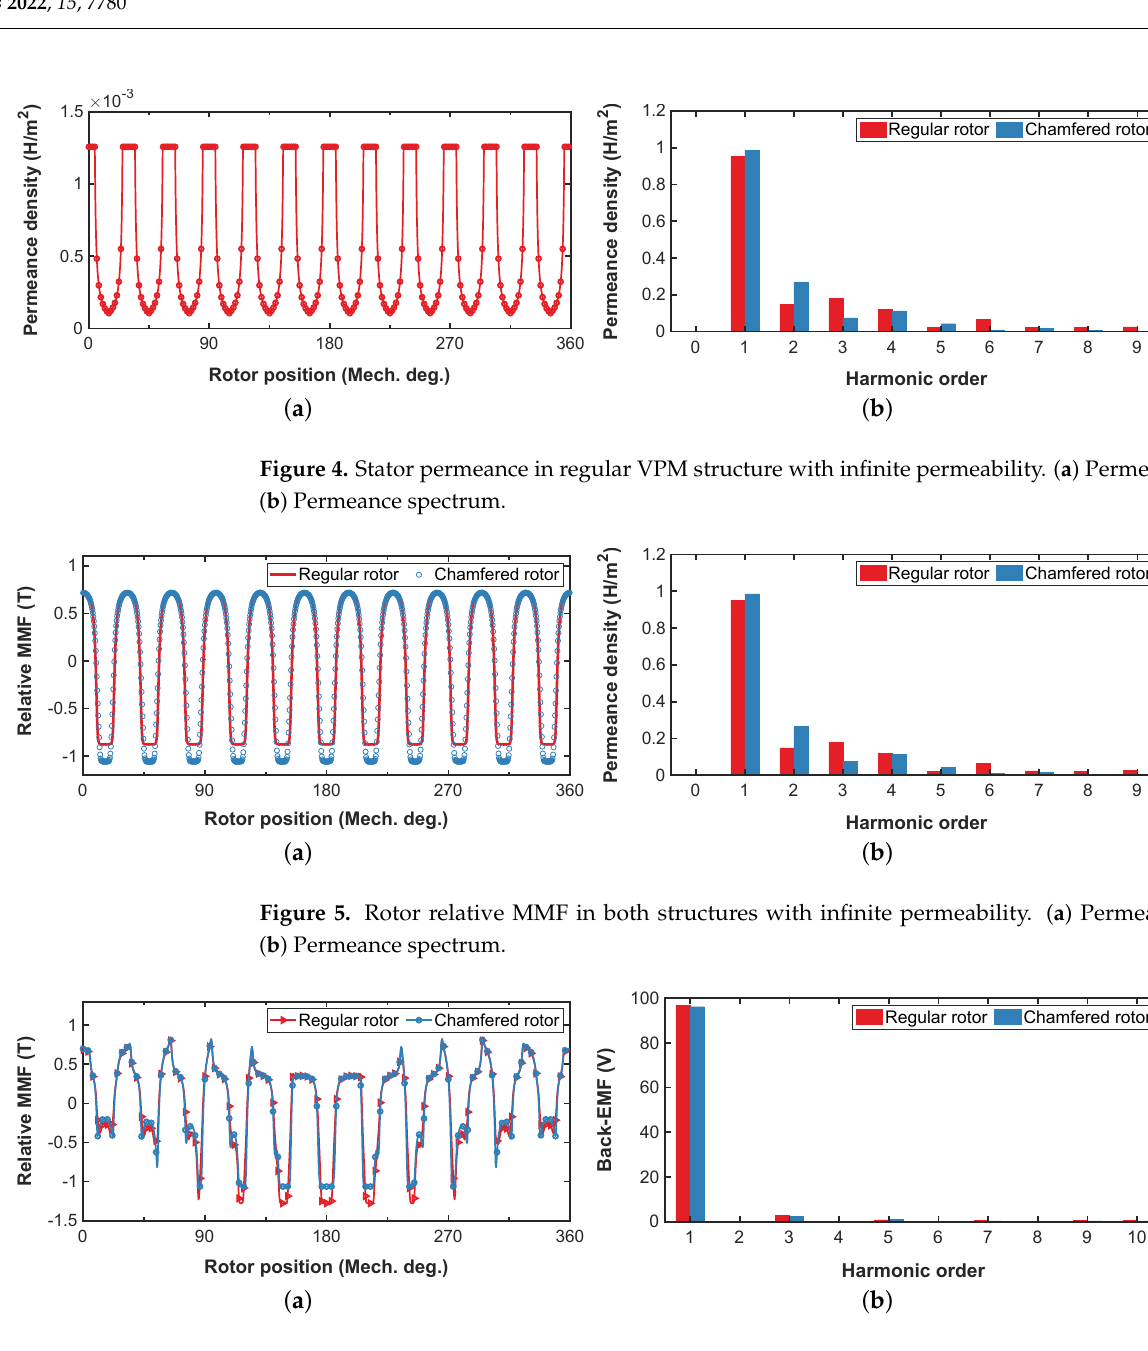
Figure 6. Air-gap flux density in both structures with infinite permeability. ( a ) Permeance plot; ( b ) Permeance